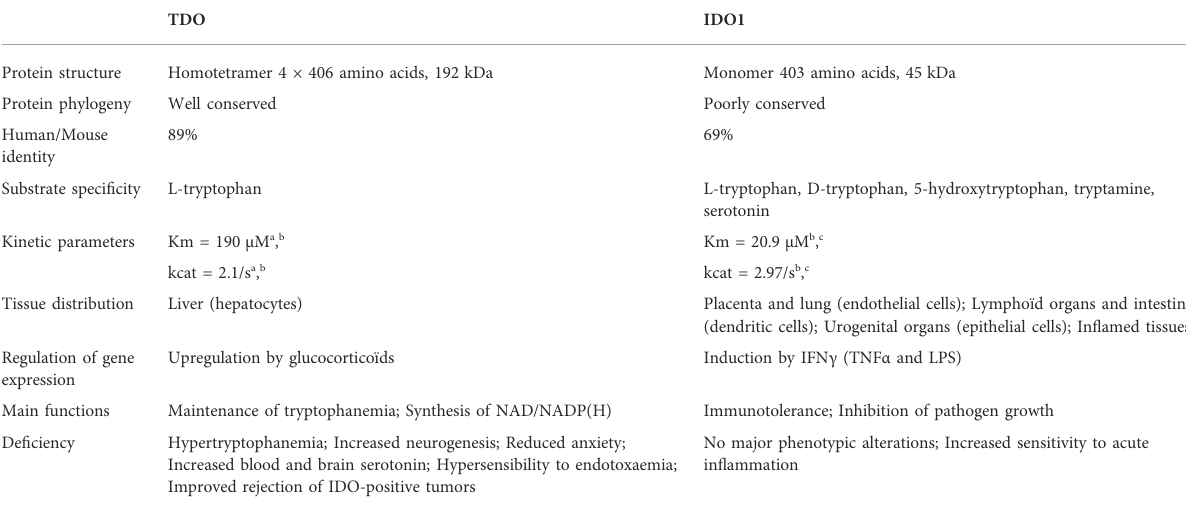
TABLE 1 Comparison of IDO1 and TDO